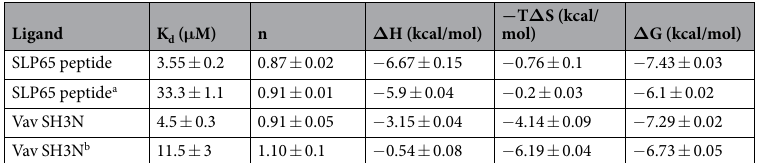
Table 1. Thermodynamic parameters obtained using ITC for the binding of Grb2 SH3C with the SLP65 peptide and Vav SH3N. a The ligand was added to the Grb2-Vav binary complex, giving rise to Complex 1. b The ligand was added to the Grb2-SLP65 peptide complex, giving rise to Complex 2 (trimeric